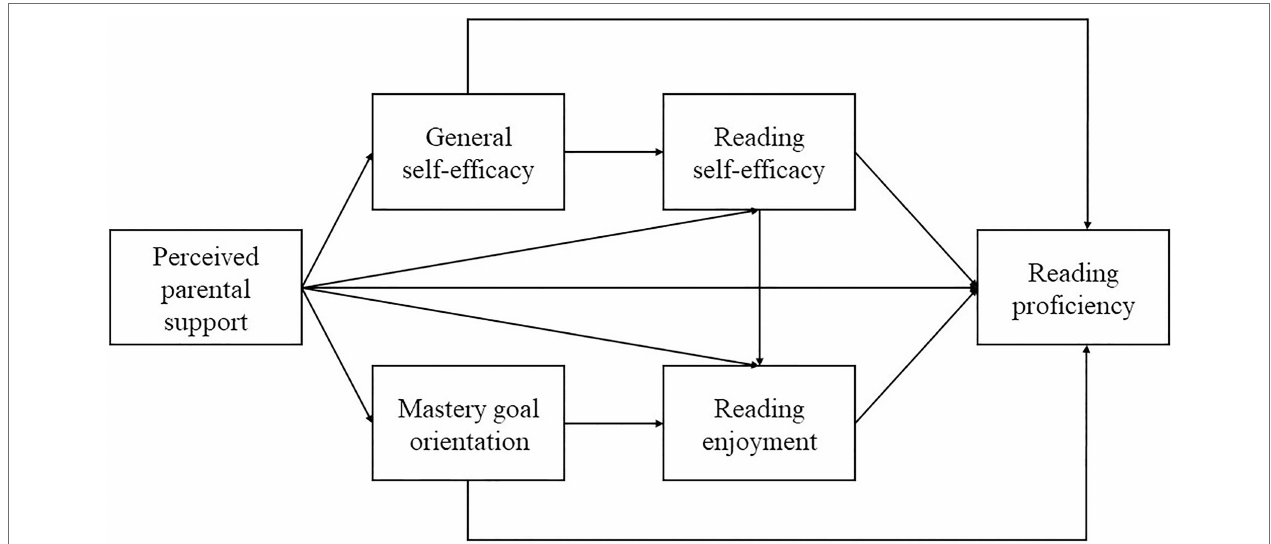
FIGURE 1 | Hypothesized model (Model 1 ) consistent with top-down theories.